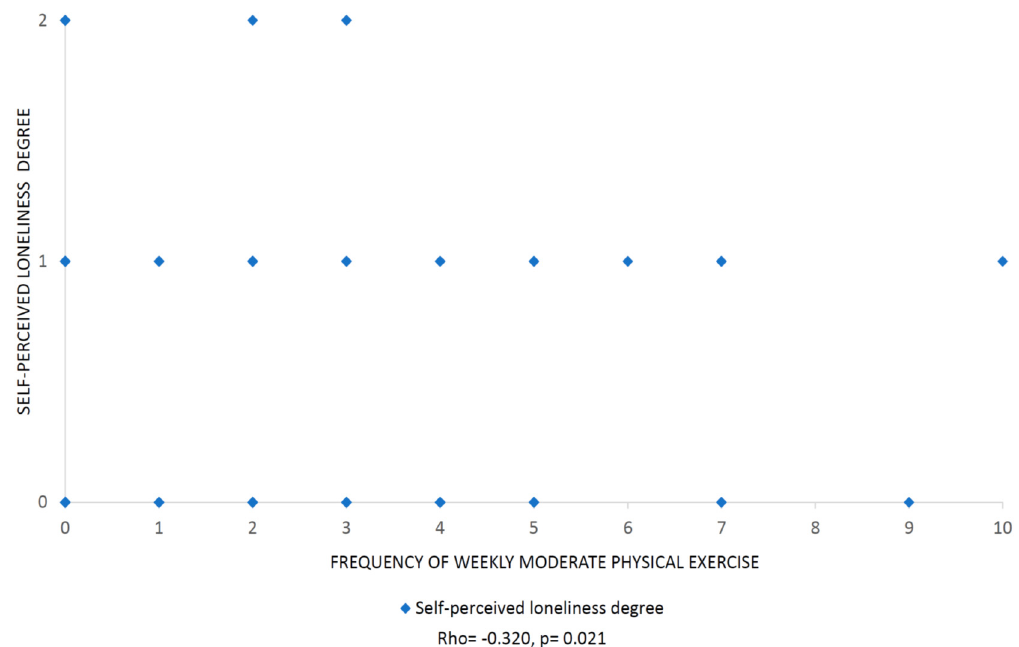
Figure 1. Degree of loneliness in relation to the frequency of moderate physical exercise per week